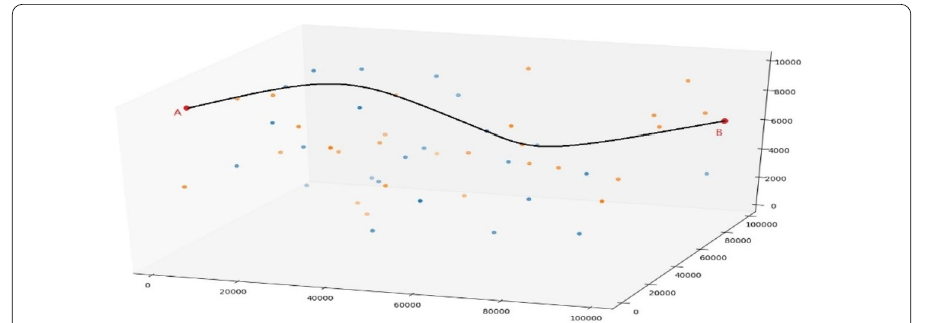
Figure 1 Schematic diagram of the aircraft route planning area